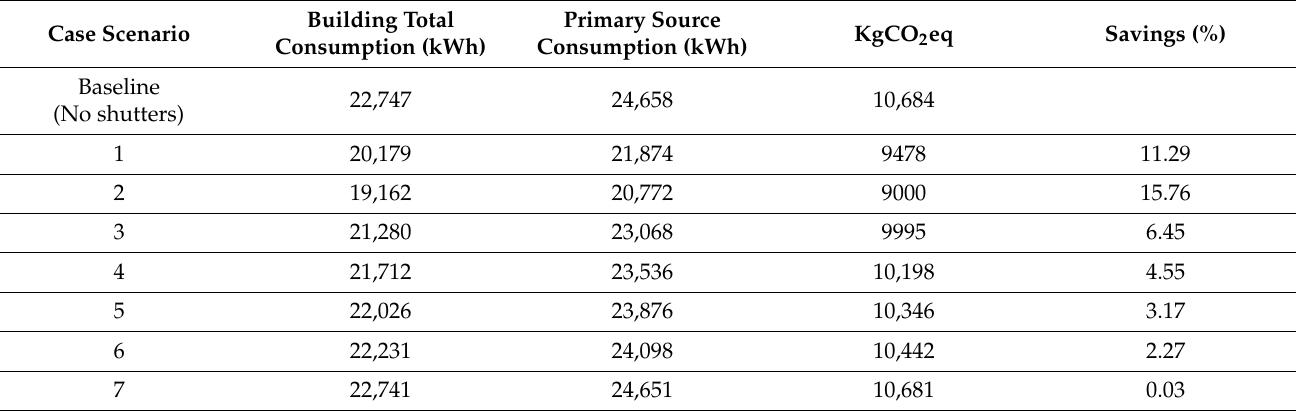
Figure 12. The reduction in dollars ( a ) and payback period ( b ) for the first case scenario: all windows have shutters and second case scenario: south and east windows have shutters with seven different windows shutter mechanism. Table 9. Prediction of equivalent CO 2 annual